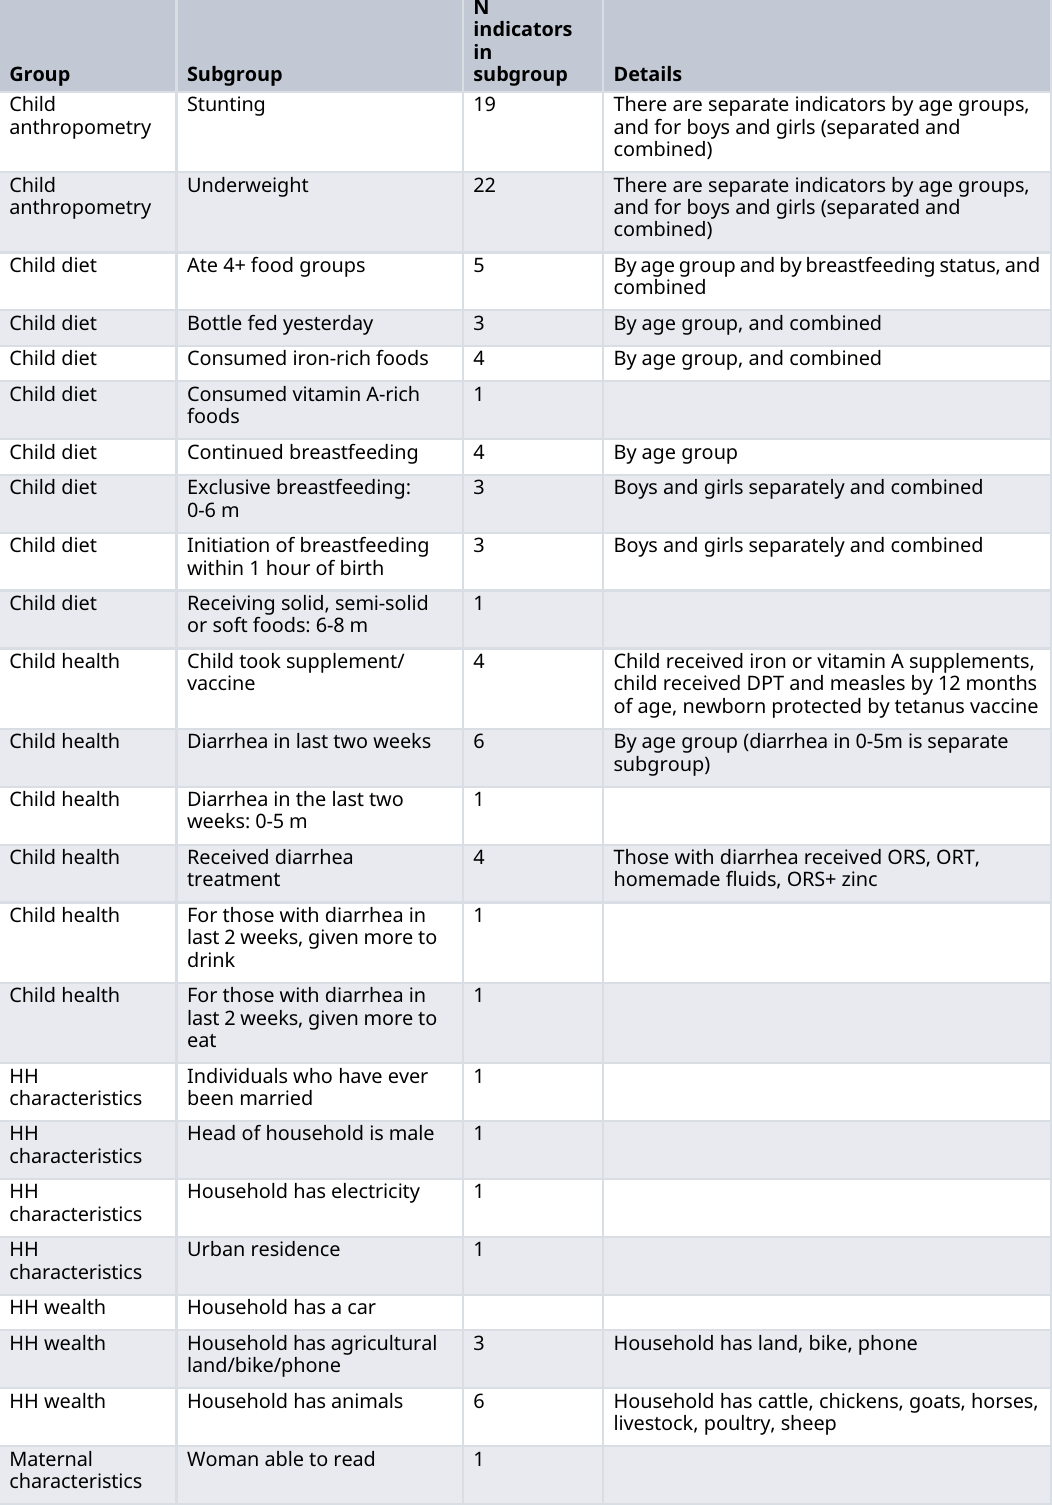
N indicators in subgroup Details